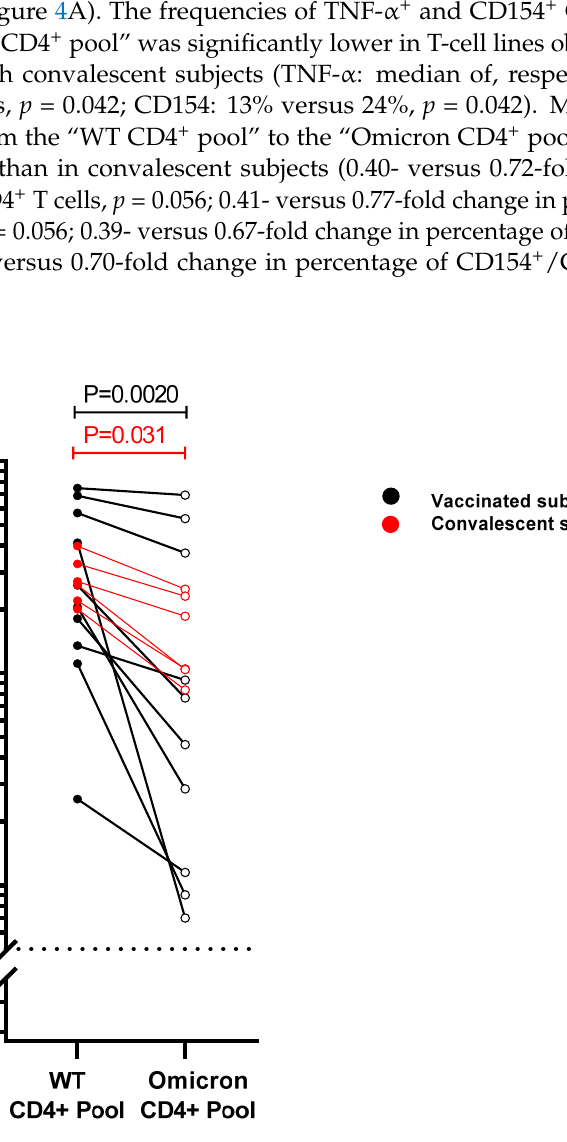
Figure 3. Reduced cross-reactivity of spike-epitope-specific T-cell lines due to mutations in the Omicron BA.1 variant in prior-vaccinated and convalescent subjects. Recognition of peptide pools of spike protein of D614G wild-type (WT) SARS-CoV-2 strain versus the BA.1 Omicron BA.1 variant by polyclonal-epitope-specific T-cell lines in IFN- È ELISPOT assay. T-cell lines were generated by 14-day in vitro stimulation of PBMCs from vaccinated (black dots/lines) and convalescent individuals (red dots/lines) with a pool of selected CD4 + T-cell epitope candidates from the WT strain (WT CD4 + pool) in the presence of IL-2. Subsequently, cells were stimulated for 24 h with ( A ) a pool of overlapping peptides for the entire spike protein (S1 + S2) corresponding to the WT strain versus the Omicron BA.1 variant or with ( B ) the “WT CD4 + pool” versus the corresponding sequences of the Omicron BA.1 variant. Each pair of dots connected with line represents SARS-CoV-2-specific IFN- È + T-cell response of one subject responding to WT versus Omicron BA.1 peptides (closed dots) versus Omicron BA.1 peptides (open dots). Dotted line indicates threshold for IFN- È -positive responses. Pairwise comparison of T-cell responses to WT and Omicron BA.1 peptide pools assessed by Wilcoxon signed-rank T test revealed a significant reduction in response to both Omicron peptide pools in both vaccinees and convalescent subjects. SFU—spot forming units.